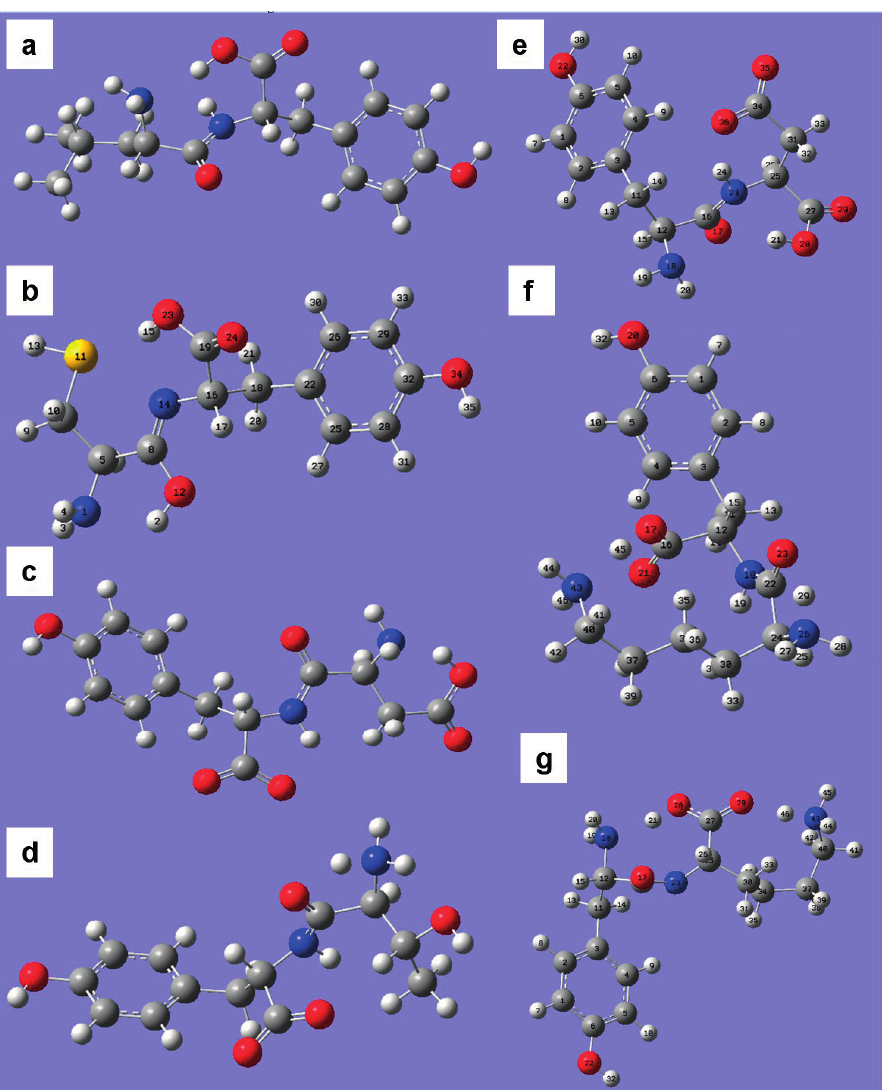
Figure 7. The structures of tyrosine-containing dipeptides in vacuum: Leu-Tyr ( a ); Cys-Tyr ( b ); Asp-Tyr ( c ); Thr-Tyr ( d ); Tyr-Asp ( e ); Lys-Tyr ( f ); Tyr-Lys ( g ). The C atoms are shown as grey, H—white, O—red, N—blue, S—yellow. For most of the dipeptides (Ile-Tyr, Tyr, Trp, Cys-Tyr, Val-Tyr, Tyr-His, Ser-Met, Met-Ala, Met-Gln, Met-Phe, Met-Thr, Gln-Met, Gly-Met) in the gas phase, the most thermodynamically preferred is the formation of the enol form of the peptide bond, which is stabilized with two hydrogen bonds with N- and C-terminal amino and carboxyl groups (Figure 7b). Some peptides (e.g., Thr-Tyr-, Figure 7d) form two hydrogen bonds between the atoms involved in the formation of the peptide bond and N- and C-terminal amino and carboxyl groups. In all analyzed tyrosine dipeptide structures in vacuum the spatial remoteness of phenolic hydroxyl excludes the possibility of its participation in the formation of hydrogen